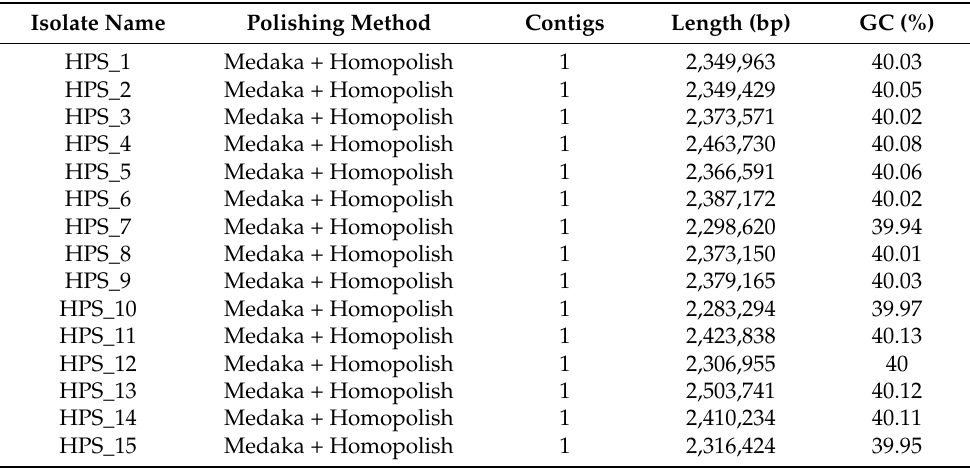
Table 7. Summary of assemblies of 15 isolates of H. parasuis